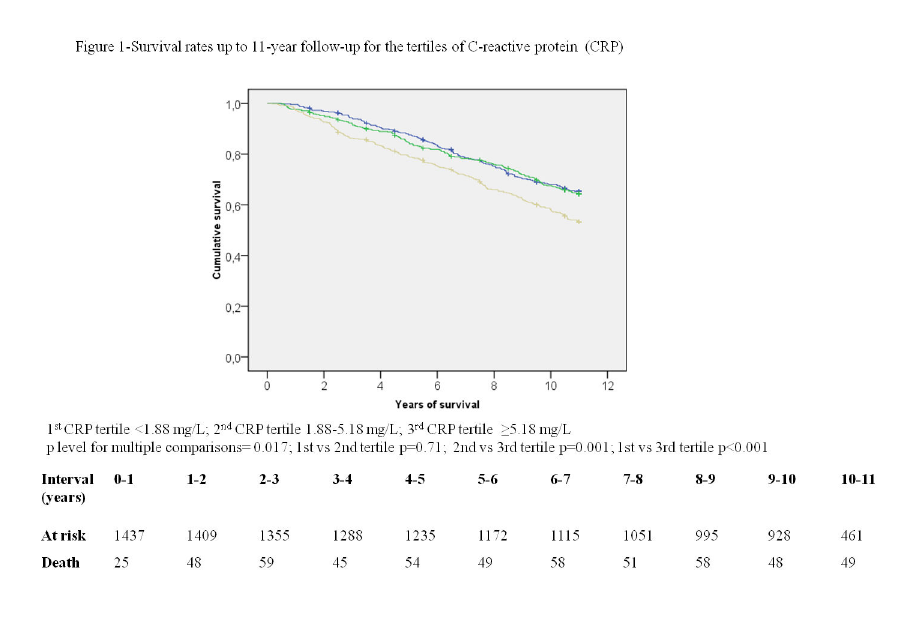
Figure 1. Survival rates up to 11-year follow-up for the tertiles of C-reactive protein (CRP).